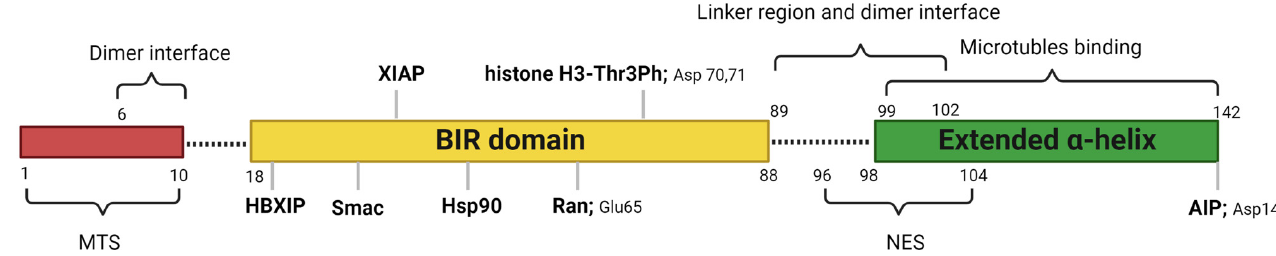
Figure 1. Critical features of survivin structure and its interaction sites with its key partners. Survivin has a single BIR domain (18–88 aa), a linker region (89–102 aa), and an extended α helix (99–142 aa) in its C-terminal. The first 10 amino acids in its N-terminus are proline-rich and represent the MTS for mitochondrial importation of survivin. The BAR domain is functionally significant for survivin interactions with Smac, Ran, XIAP, HBXIP, and histone 3 of the centromeric chromatin. The linker region mediates the dimerization along with residues 6–10 in the N-terminal region of the survivin. Borealin replaces one survivin monomer through the dimer interface to form a survivin–borealin heterodimer. The C-terminal of survivin, the N-terminal of borealin, and INCENP form the triple helix unit as part of CPC. The survivin helical region has tubulin- and AIP-binding sites. Survivin has an NES between the BIR domain and the C-terminal helix, which is masked by the homodimerization interface. Moreover, survivin has a non-classical bipartite NES in the C-terminal. This figure